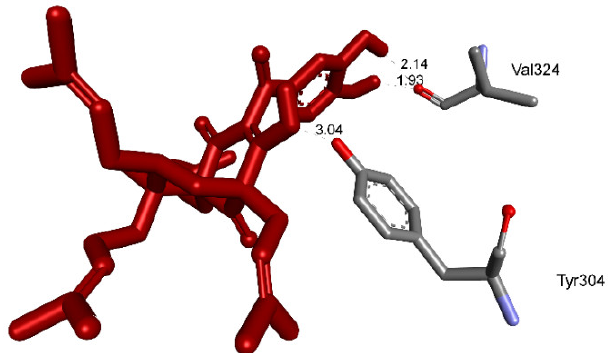
Figure 18. Ligand map presenting the secondary interactions between pose 158 and active residual amino acids on enzyme 2VF5.